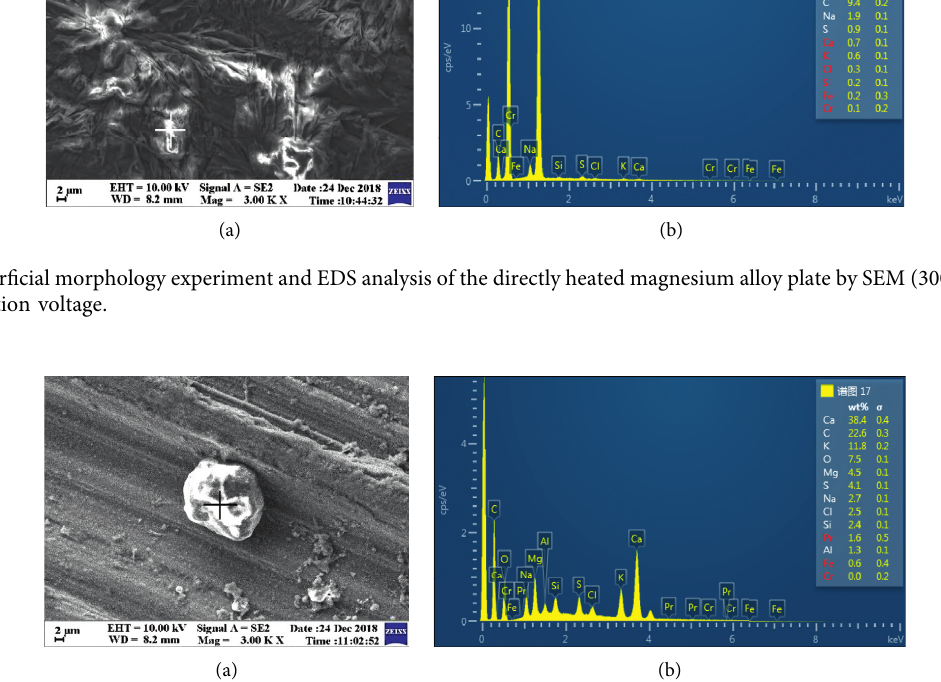
Figure 15: Superficial morphology experiment and EDS analysis of the directly heated magnesium alloy plate by SEM (3000 times) without cathodic protection voltage.